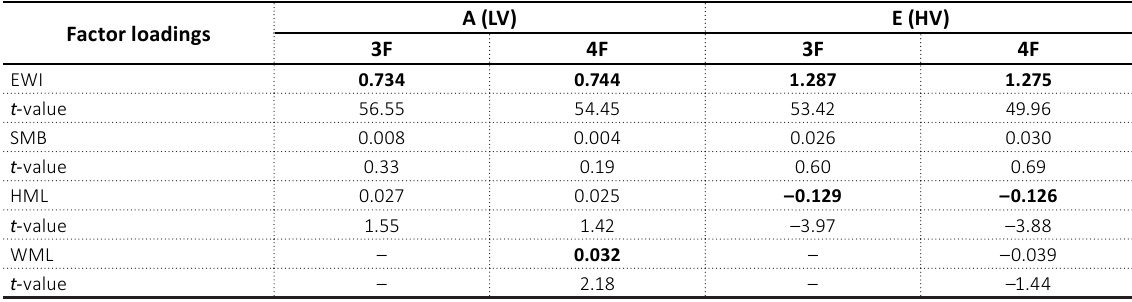
Table 14. Thr ee-factor and four-factor regression coefficients of dependent portfolios ranked on volatility and controlled for size